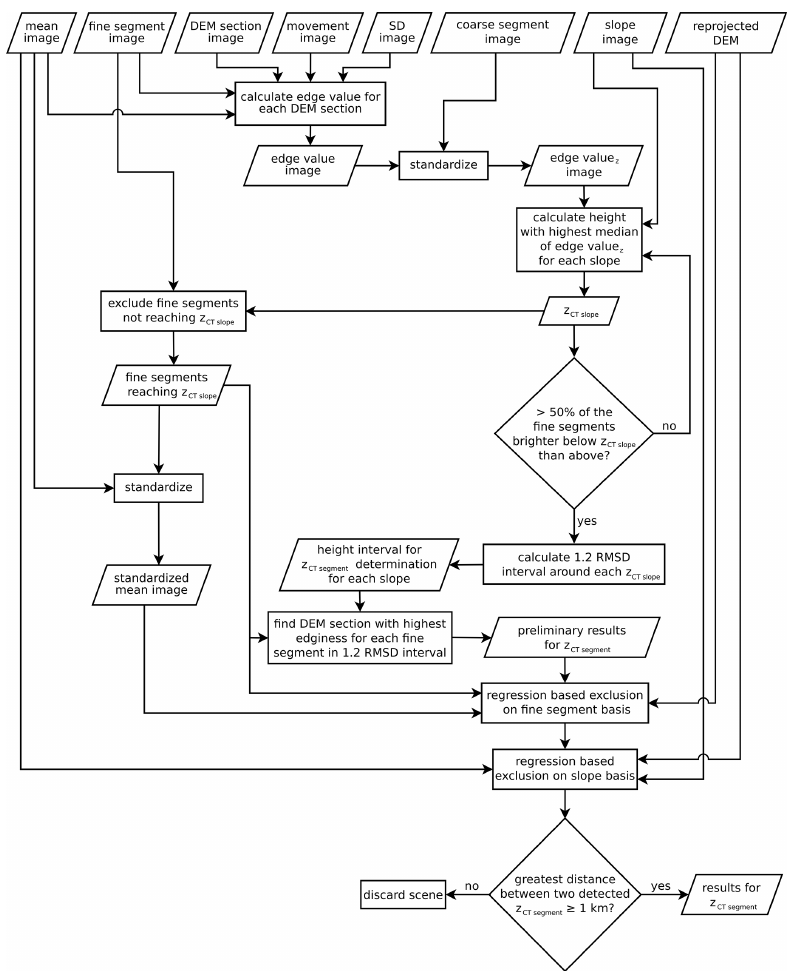
Figure 7. Simplified flowchart for the image analysis in order to derive z CT . For the sake of simplicity, the mask as an input is not shown as every processing step is restricted to the pixels that are not masked out. In addition, the height extracted from the reprojected DEM is used in a lot more steps than shown (see